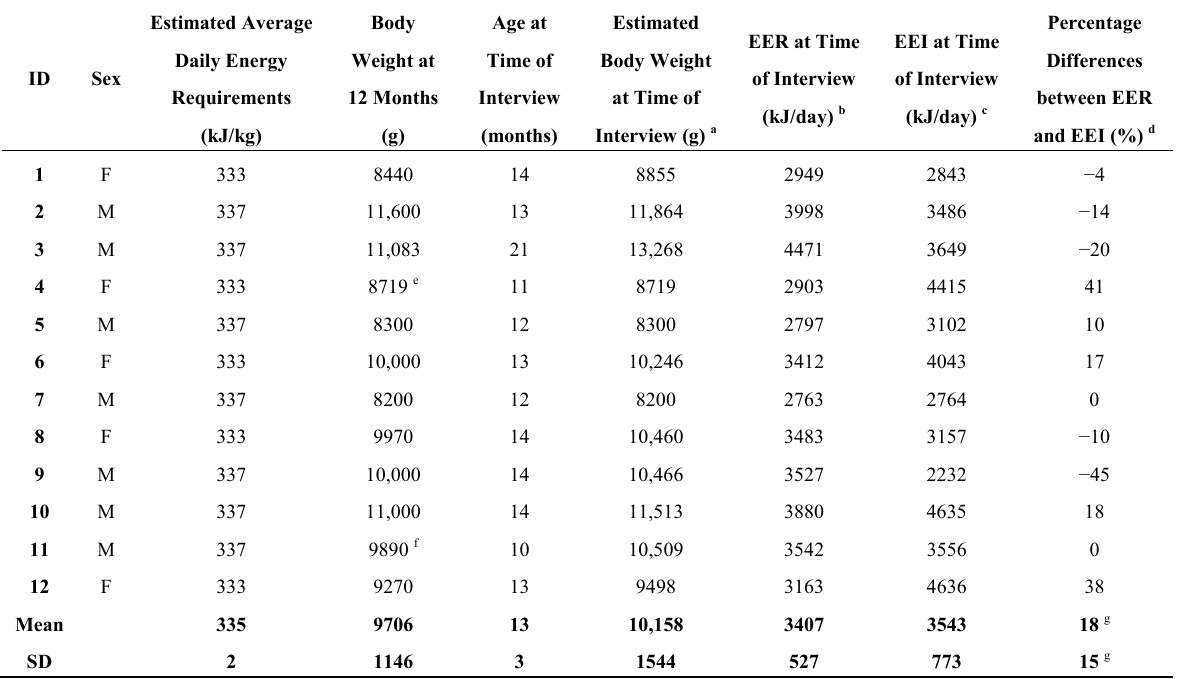
a Estimated body weight at time of interview calculated based on average growth rate from World Health Organization’s growth standards [19] multiplied by number of months between time of weighing and time of interview; b Estimated body weight at time of interview multiplied with estimated average requirement